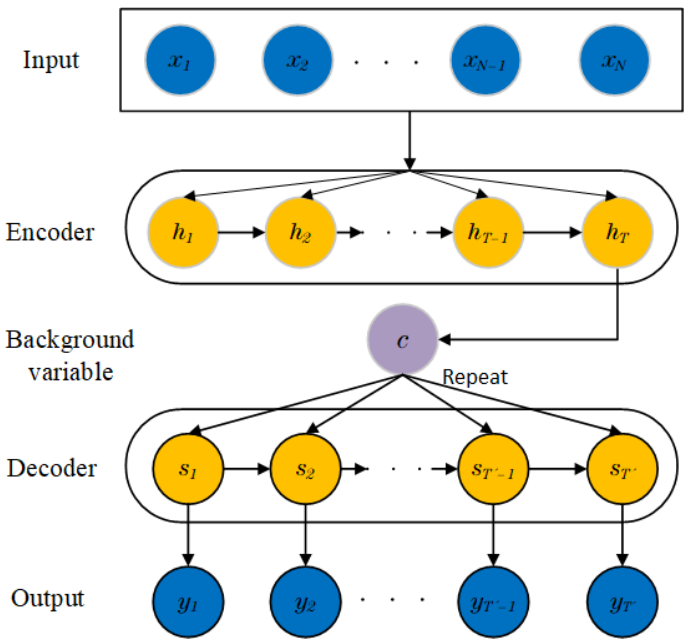
Figure 6. Structure of the RNN-based encoder–decoder.